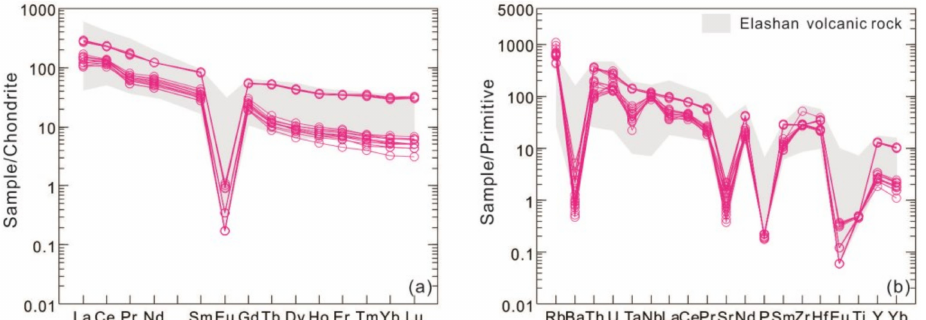
Figure 8. ( a ) Chondrite-normalized rare earth element (REE) patterns; ( b ) primitive-normalized incompatible element distribution patterns for the Keri rhyolites in the EKOB (chondrite data and primitive data for normalization taken from Sun et al. [73]). Geochemical data of Elashan Formation volcanics from references